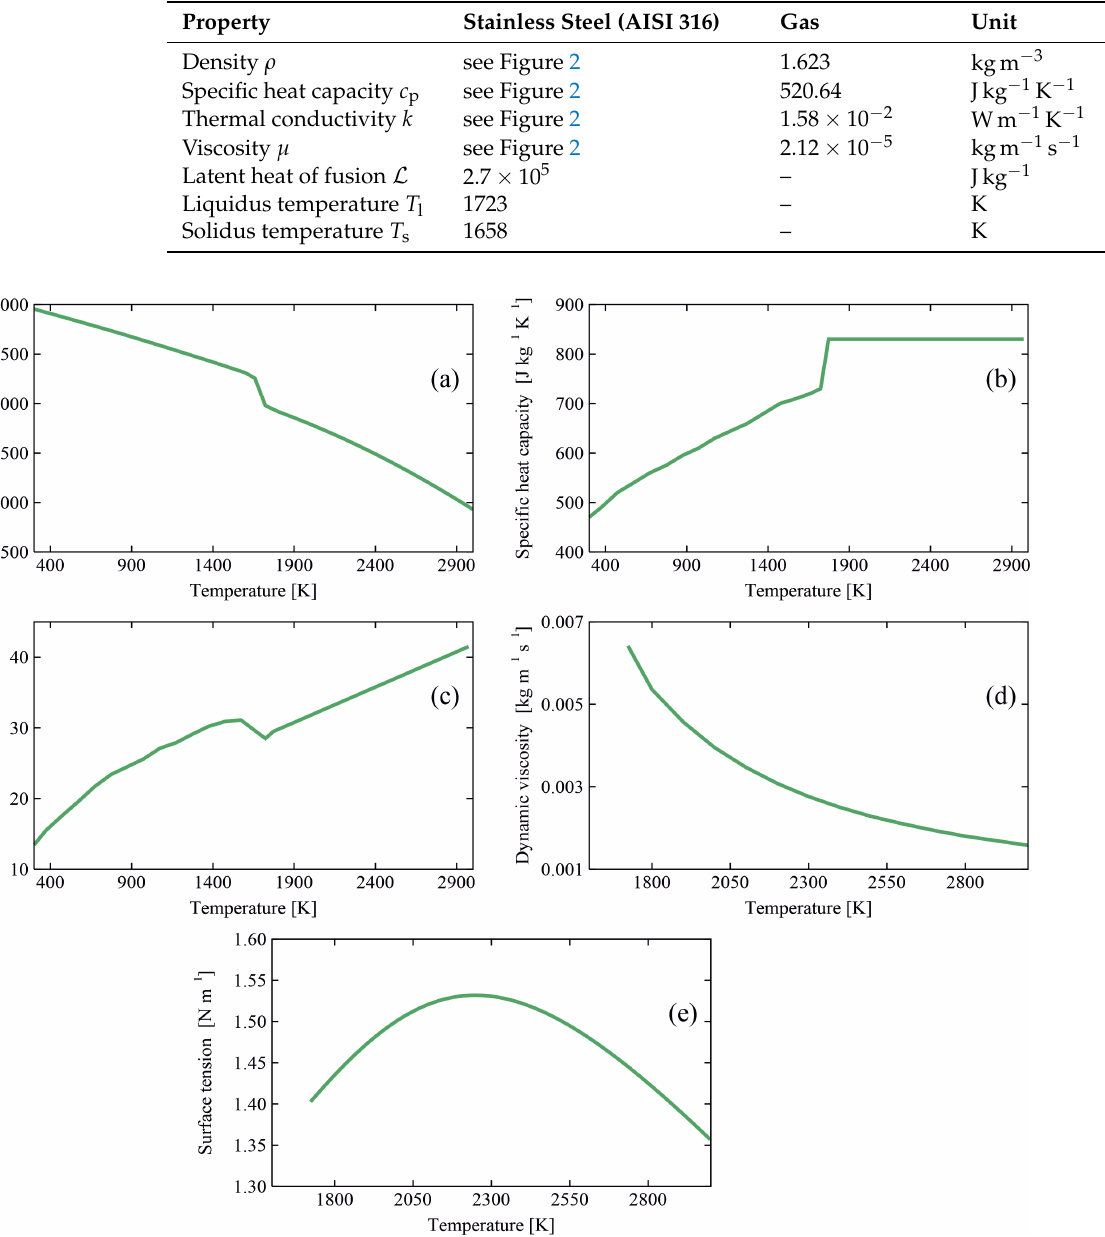
Table 2. Thermophysical properties of the stainless steel (AISI 316L) and the gas employed in the numerical simulations. Values for AISI 316 are taken from [25].